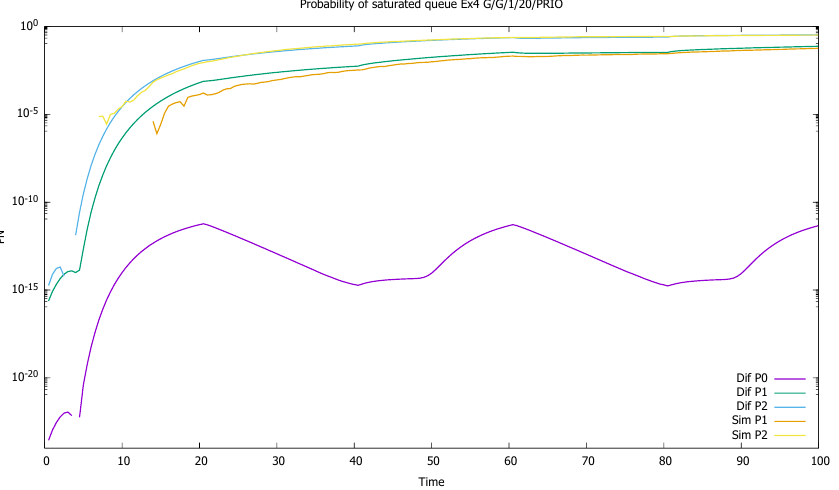
Figure 16. Section 3.4, three priorities: probabilities of saturated queues as a function of time; in case of P(0) only diffusion results are available, the simulations were too short to give such small